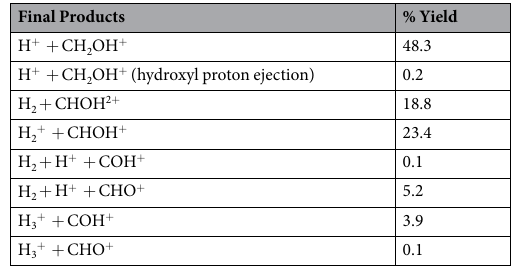
Table 2. Summary for the final products of the CASSCF trajectories after 150